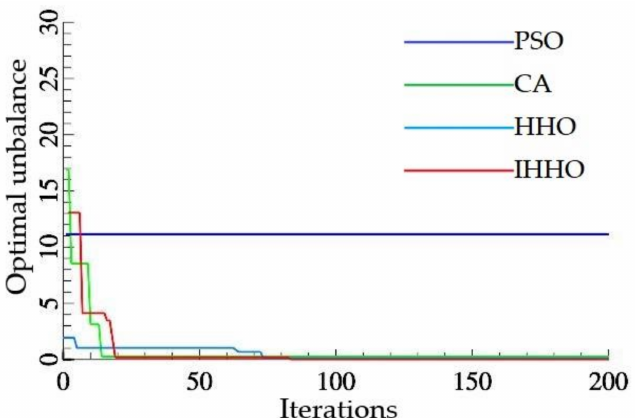
Figure 10. IHHO optimal unbalance iteration